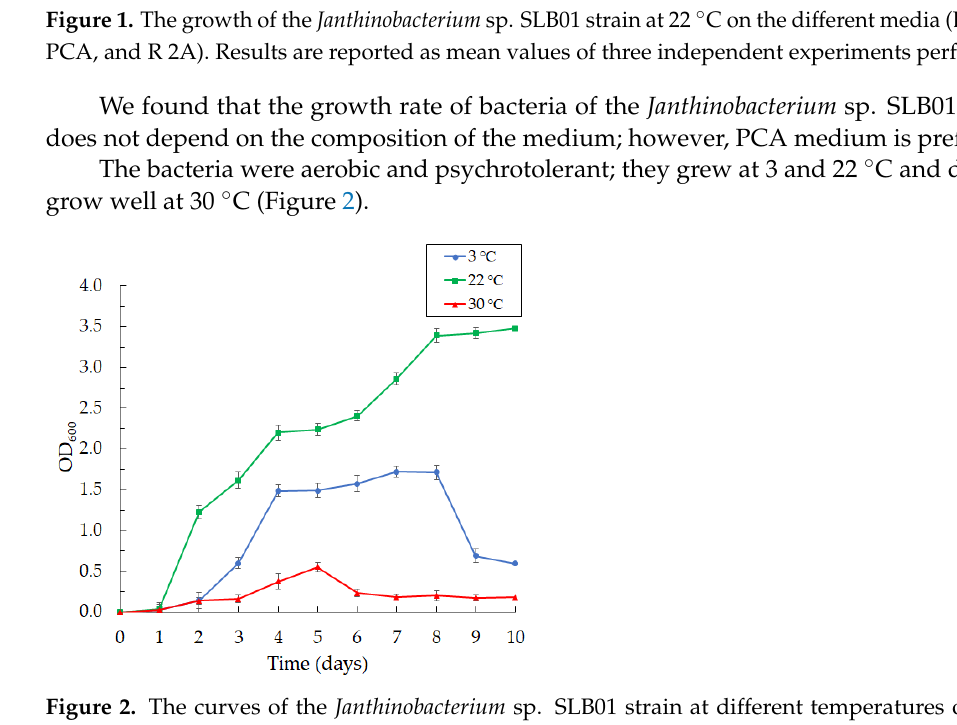
Figure 2. The curves of the Janthinobacterium sp. SLB01 strain at different temperatures of cultivation in LB broth (at 3, 22 and 30 °C). Results are shown as mean values of three independent experiments performed.